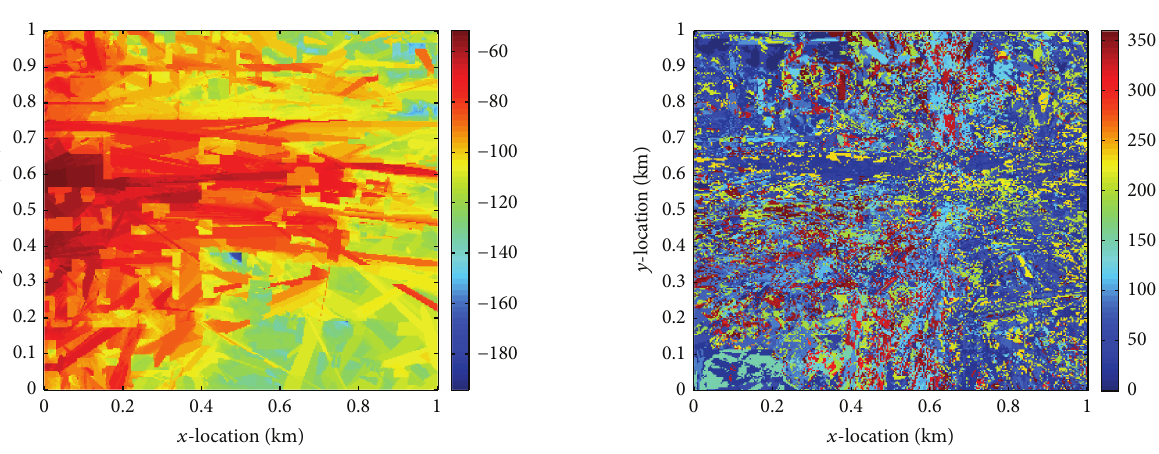
Figure 6: Simulated AOA in azimuth plane ( ∘ ) data from the MCD for downtown State College, PA, for Scenario B. Data plotted for the dominant